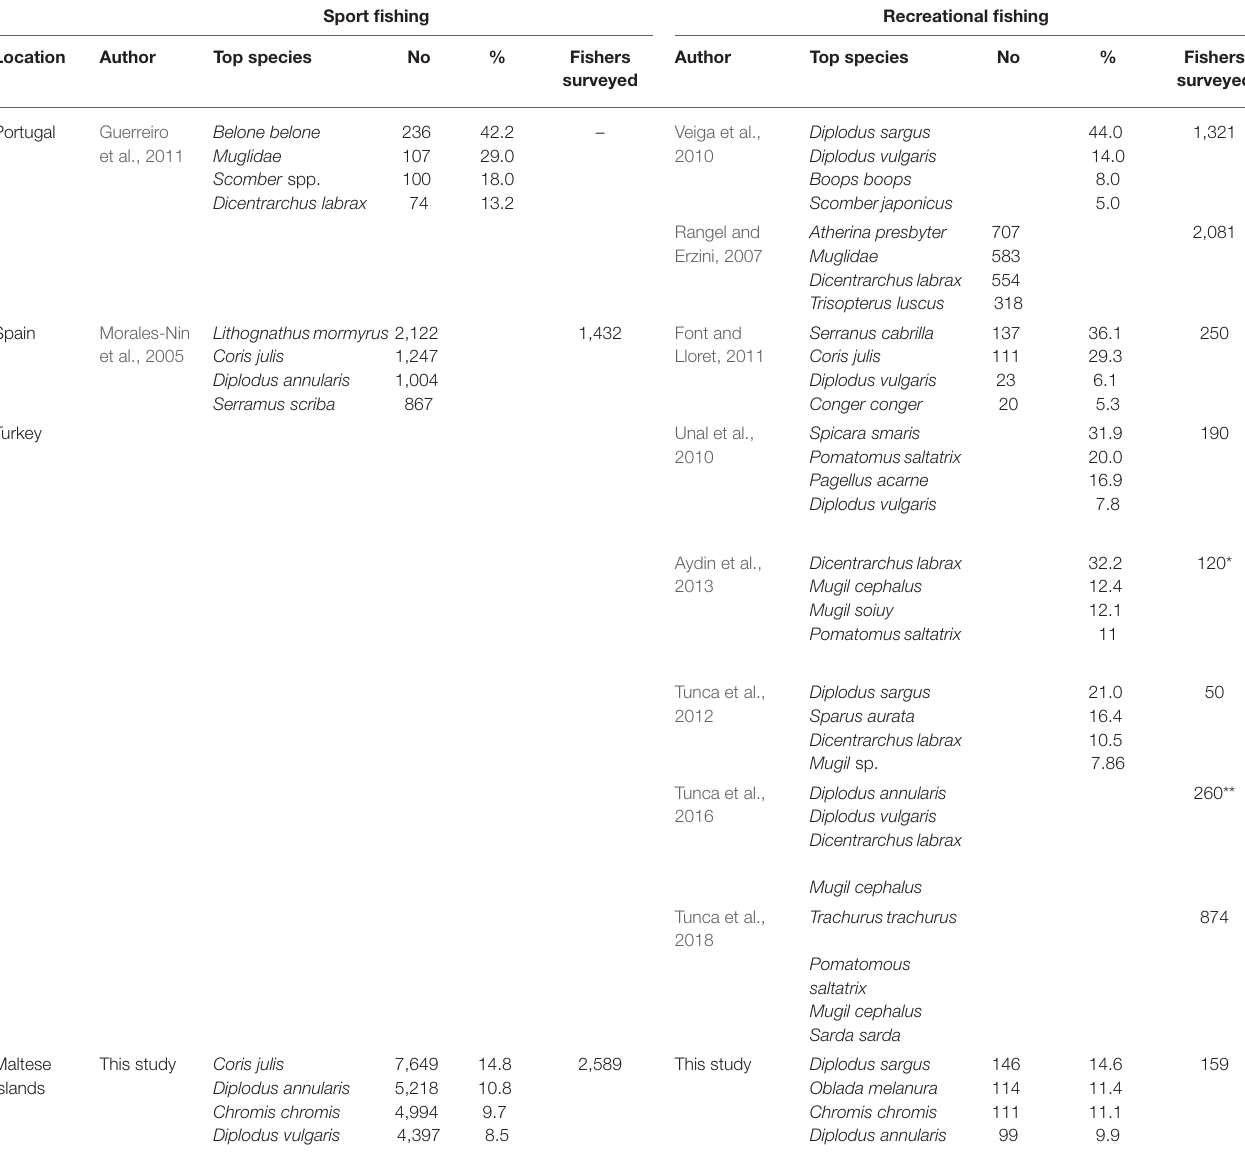
TABLE 7 | Species recorded during shore based fishing competitions and hobby fishing in the Maltese Islands and in other